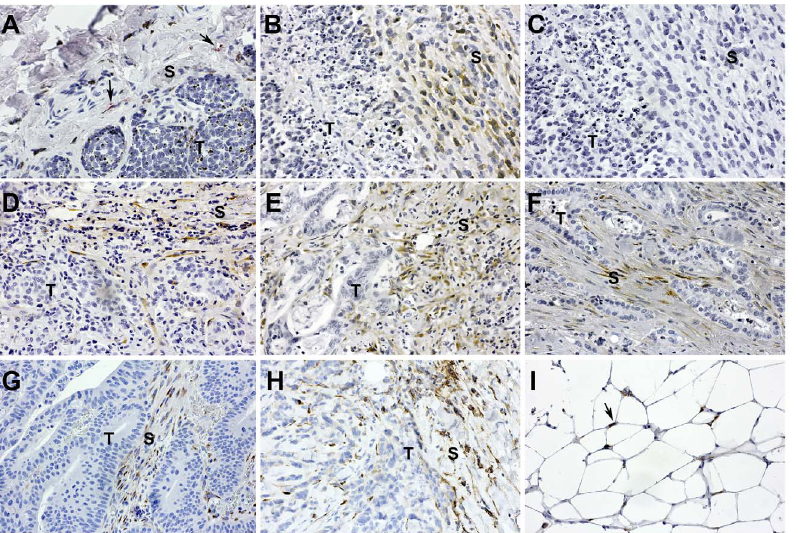
Figure 3. Cthrc1 localizes to tumor stroma. Immunolocalization of Cthrc1 was performed in various human cancers to determine protein levels in stromal cells (S) and tumor cells (T). (A) Melanoma biopsies showed few Cthrc1-positive stromal cells surrounding the tumor (red stain, arrows). (B) Endometrial cancer had abundant Cthrc1 positive stroma adjacent to necrotic tumor area. (C) The endometrial cancer was stained with an irrelevant rabbit monoclonal antibody to ensure specificity. Tumor stroma from (D) breast ductal carcinoma, (E) colon adenocarcinoma, (F) pancreatic adenocarcinoma, and (G, H) lung carcinoma had abundant Cthrc1 protein localization surrounding the tumor cells. (I) Some adipocytes adjacent to the tumor had Cthrc1 expression (arrows). Cthrc1 immunoreactivity in brown (except A) with hematoxylin counterstain. Original magnification 200x.